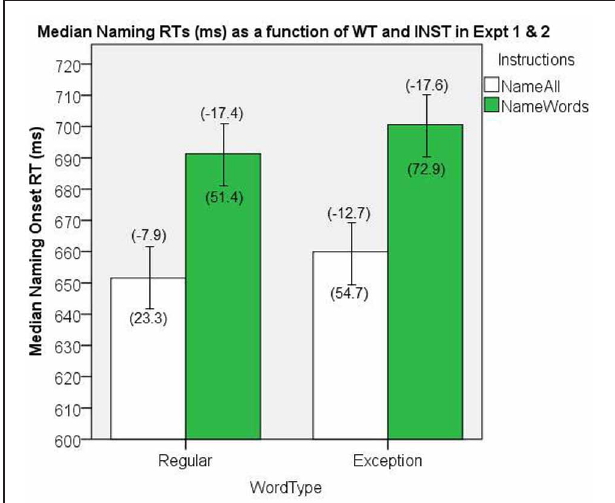
FIGURE 11 | Median Naming RTs (in ms) as a function of WT and INST in the combined analysis of Experiments 1 and 2. The 95% C.I.s are presented as error bars using Loftus and Masson’s (1994) method. Co-efficients relating WF to RT (ms/log 10 HALWF) are presented in parentheses above each error bar, and co-efficients relating SND to RT (ms/unit inverseNcount) are presented in parentheses below each error